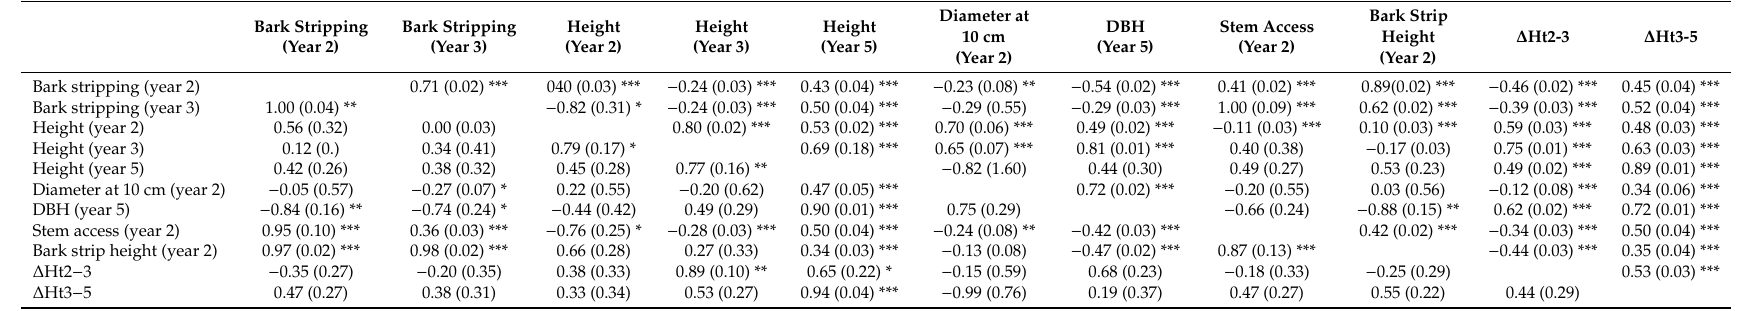
Table 8. Phenotypic (above diagonal) and genetic Type A (below) correlations of the traits that were assessed in the Wilmot trial with the standard errors given in parentheses. The significance of the di ff erence of the correlations from zero are indicated: *** = p < 0.001, ** = p < 0.01, * = p < 0.05. ∆ Ht2 − 3 = Height (year 3)